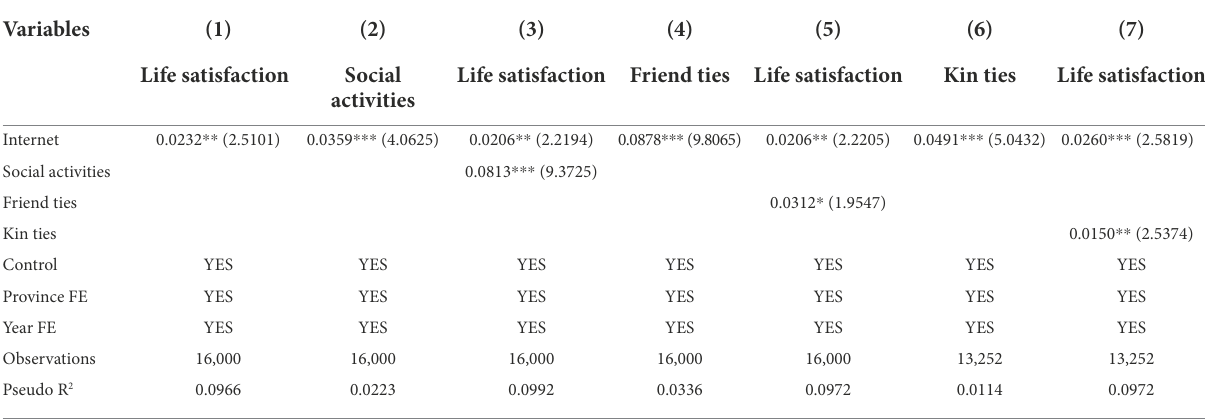
TABLE 7 Life satisfaction mechanism